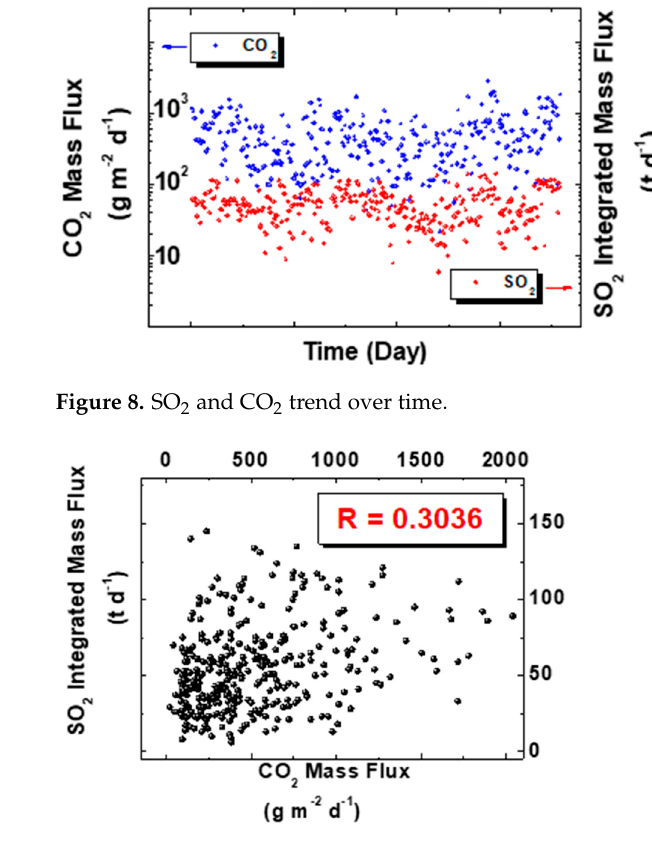
Figure 9. Correlation between SO 2 and CO 2 .